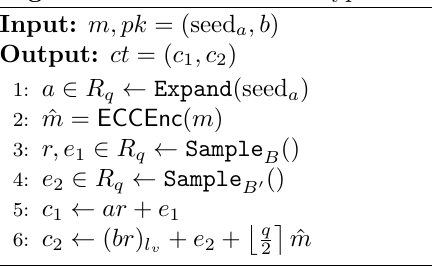
Algorithm 8 LAC CPA